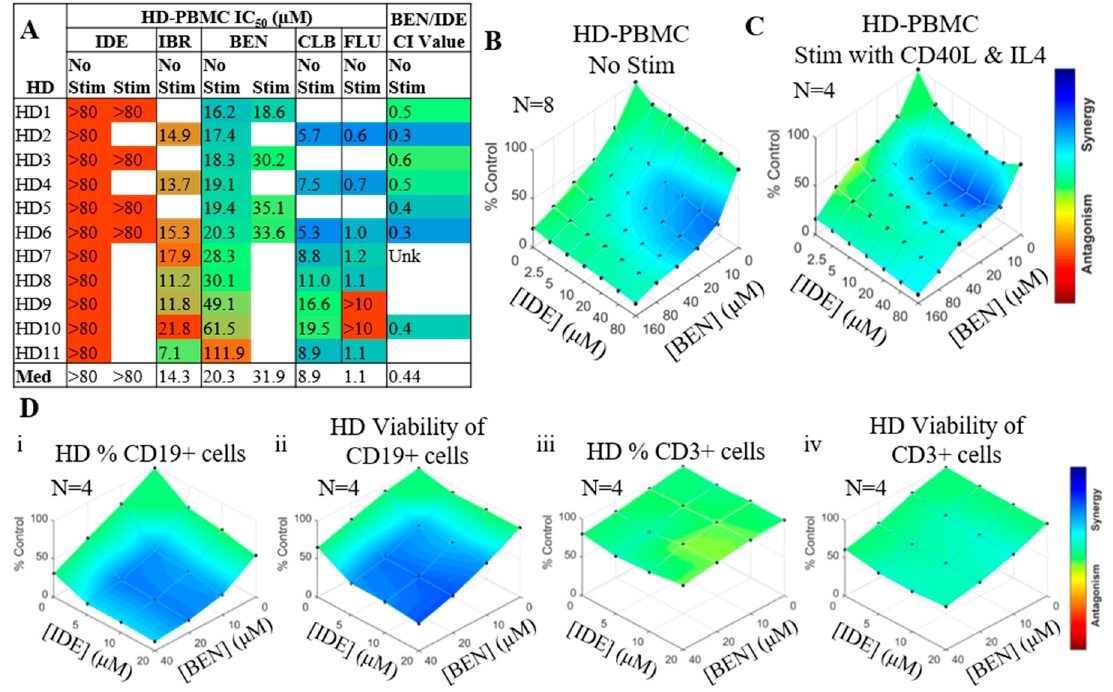
Figure 4. Idelalisib (IDE) / bendamustine (BEN) are synergistic in non-chronic lymphocytic leukemia (CLL) donor peripheral blood mononuclear cells (PBMCs). ( A ) Table showing differences in response of age matched non-CLL healthy donor (HD)-PBMCs to single agent drugs or BEN/IDE combination index (CI) value. Unk = unknown. ( B , C ) IDE and BEN synergy in HD-PBMCs without ( B ) or with ( C ) CD40L/interleukin 4 (IL4) stimulation. ( D ) BEN/IDE synergy in i) the number of, or